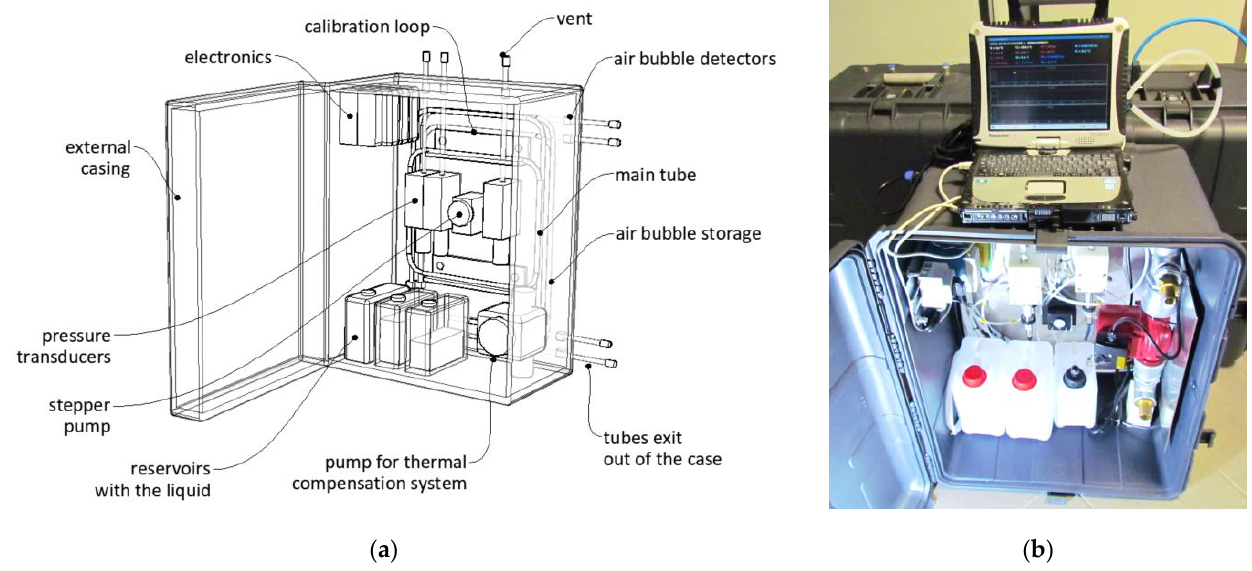
Figure 8. Hydraulic system designed for automatic operation of new sensor: ( a ) special visualization with key components; ( b ) the view of the case applied within filled measurements.